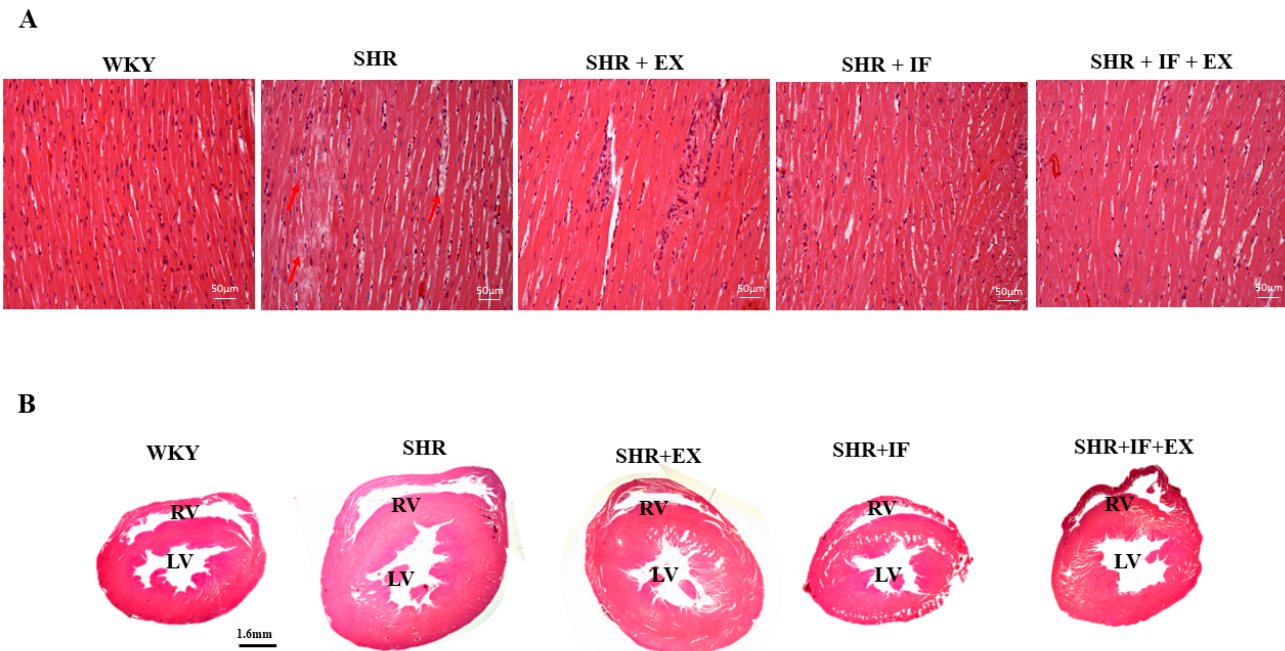
Figure 3. Effect of IF peptide and exercise training on histological changes in heart morphology of hypertension rats. ( A ) HE staining. Red arrow showing histological alterations in SHR rats ( B ) Tomography of cardiac tissues. RV, right ventricle; LV, left ventricle.